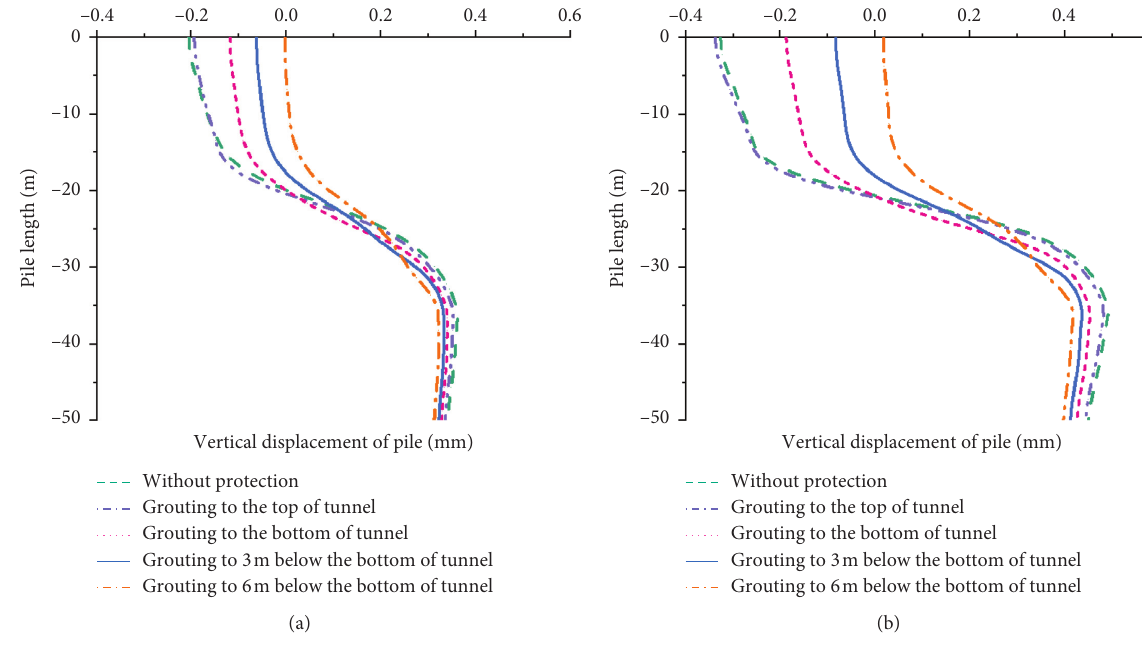
Figure 7: Vertical displacement of the pile: (a) 2 rings before arriving at the pile; (b) arriving at the